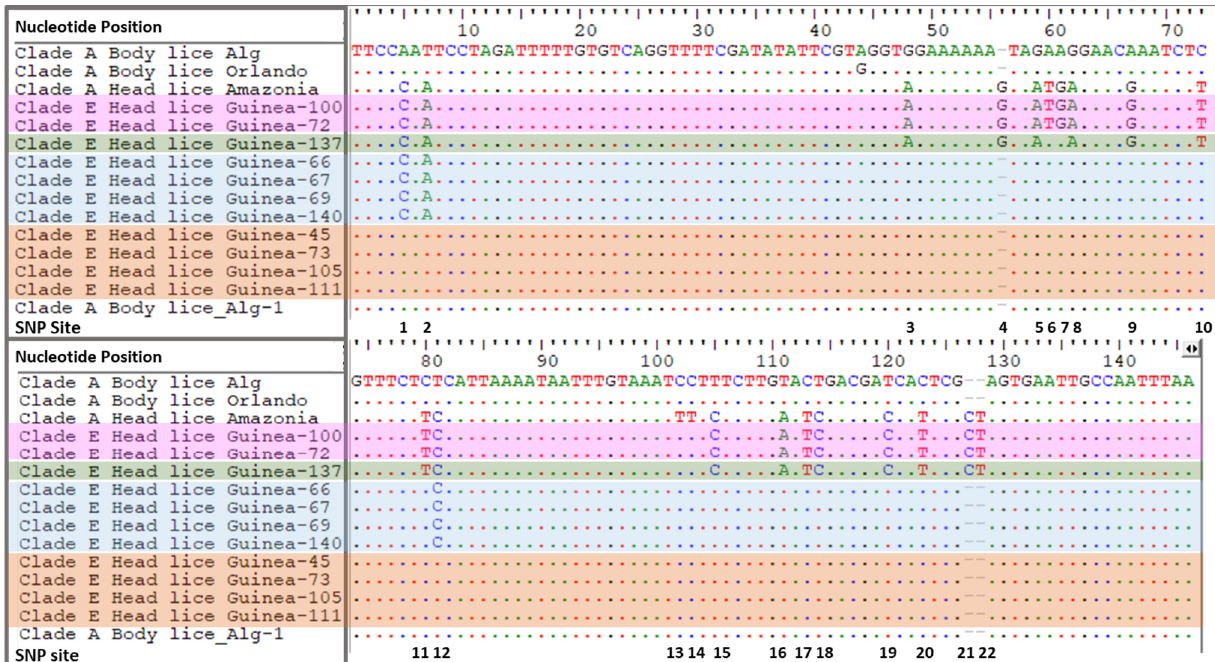
Figure 4. Alignments of a portion of Guinean head lice-Phum_PHUM540560 gene sequences with those from body and head lice reported in this study and previously in the literature. HL Amazonia [40] represent the 22 SNPs that are specific to clade A-head lice. BL Algeria (Alg) and Orlando represent the PHUM540560 gene profile specific to clade A-body lice. HL Guinea group contains 11 specimens: Orange block nucleotide represent 0 SNPs specific to head lice, blue block nucleotides represent 3 SNPs specific to head lice; green block nucleotides represent 18 SNPs specific to head lice and pink block nucleotides represents 20 SNPs that are specific to P.h. capitis. BL: body louse; HL: head louse; P.h.corporis strain USDA 1103172108290 Phum_PHUM540560 (gene sequence available in GenBank accession N.